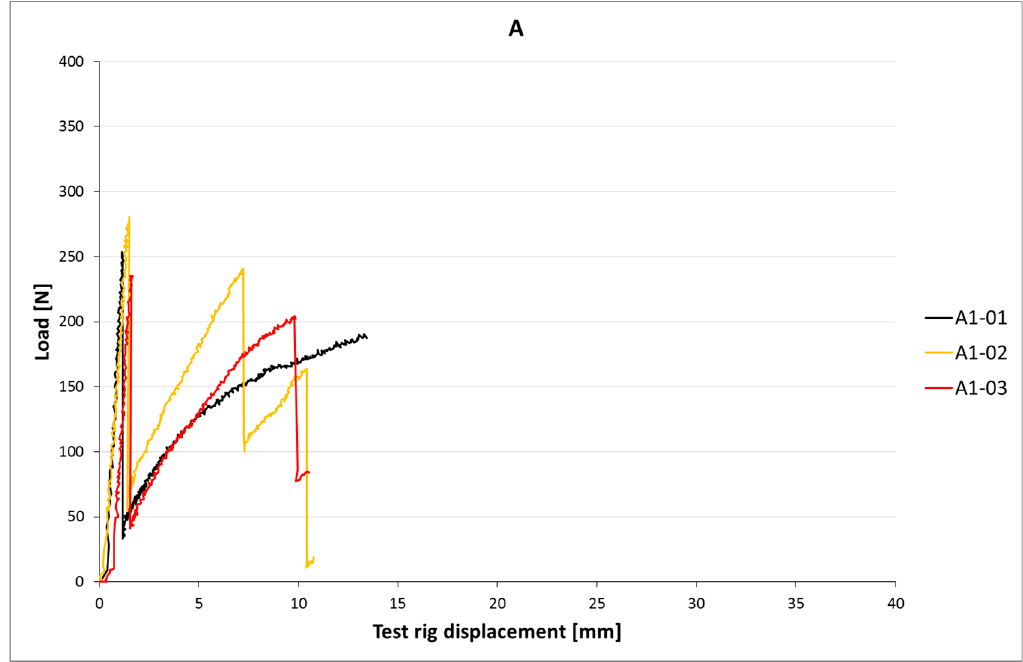
Figure 15. Load-displacement curves of printed beams with A-type cable. Figure 14. Load-displacement curves of printed beams with A-type